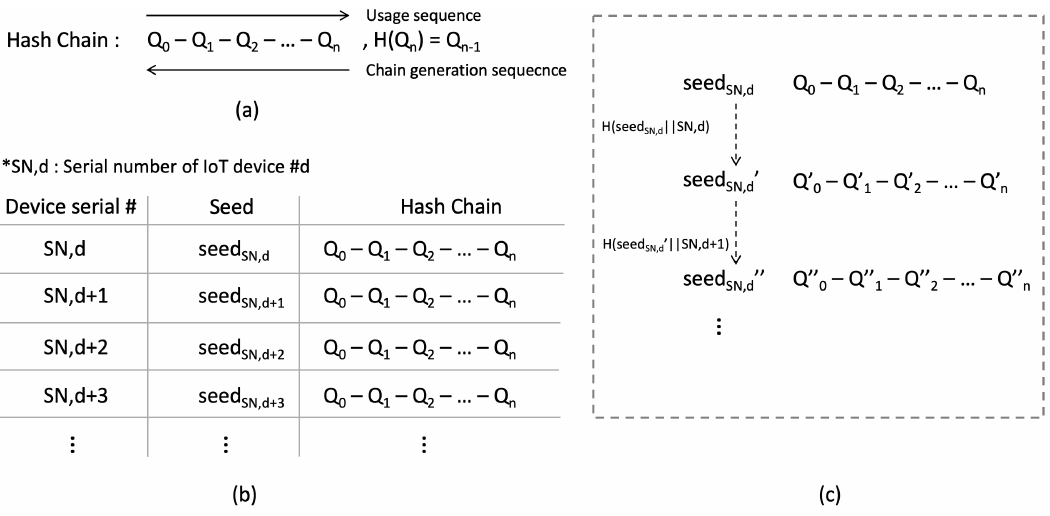
Figure 5. The hash chain. ( a ) Sequence of hash chain generation and usage, ( b ) information on seeds and hash chains of IoT devices stored in the server, ( c ) renewal of hash